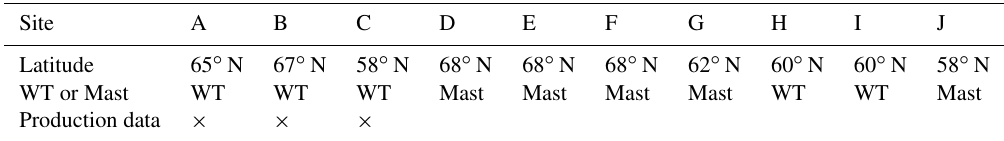
Table 1. Observation sites with approximate latitude, description if the measurements were made from a mast or at the wind turbine nacelle (WT) and available production data ( × ). Site A B C D E F G H I J Latitude 65 ◦ N 67 ◦ N 58 ◦ N WT or Mast WT WT WT Mast Mast Mast Mast WT WT